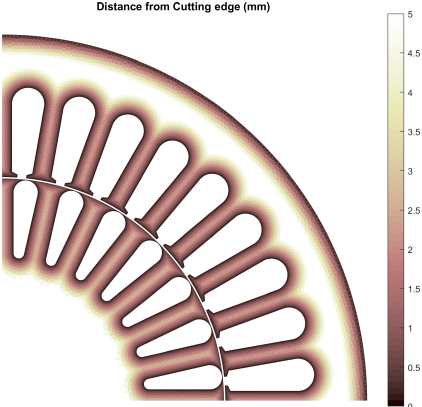
Figure 7. Distance to the closest cut edge from the center of a